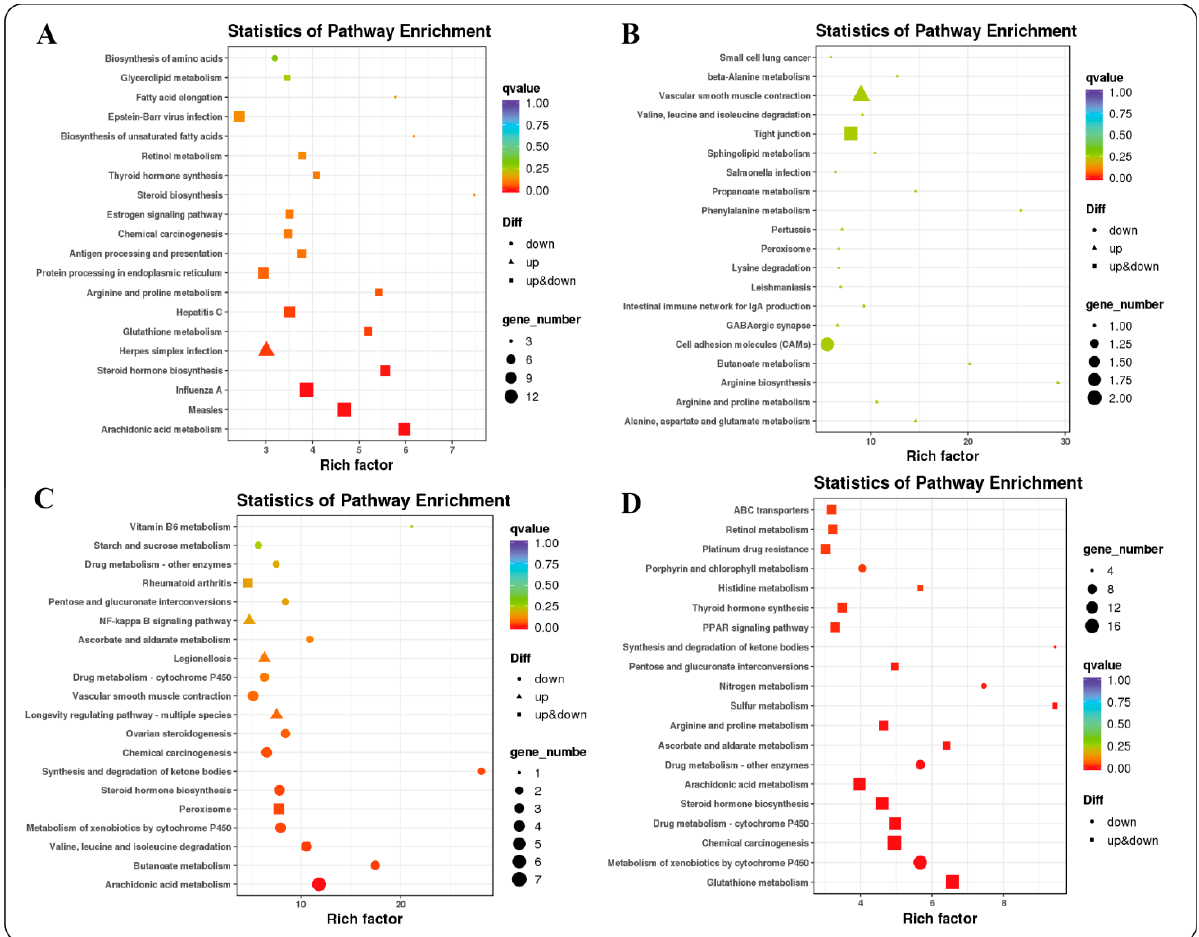
Figure 6. Functional enrichment analysis of KEGG. ( A ): 4 months_vs._1.5 years; ( B ): 1.5 years_vs._3.5 years; ( C ): 3.5 years_vs._6 years; ( D ): 4 months_vs._6 years.